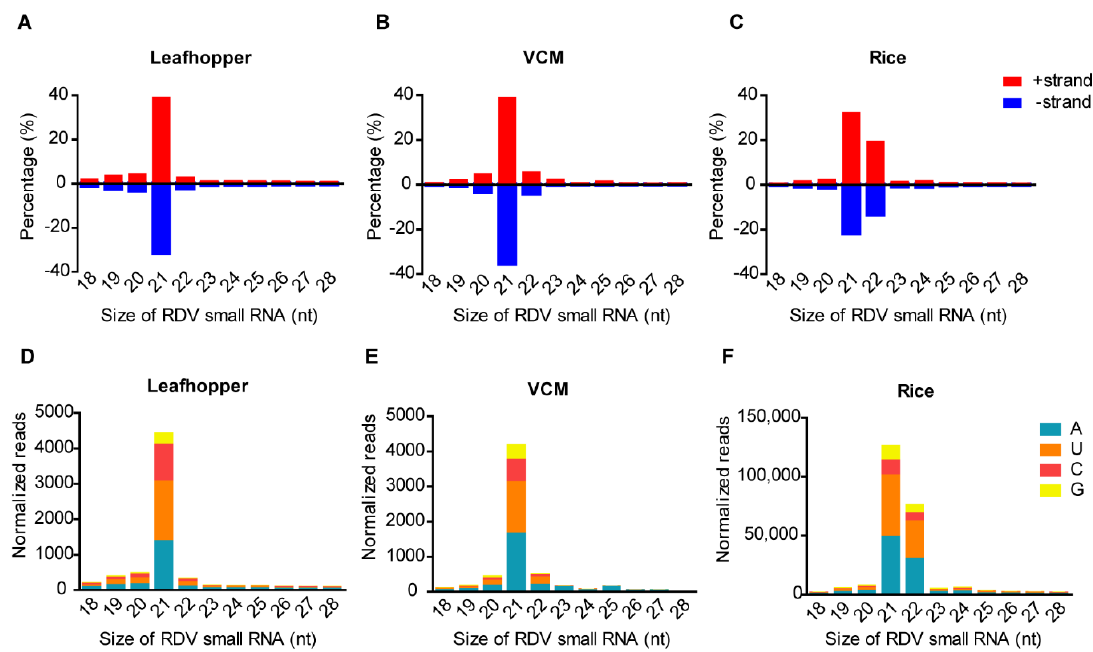
Figure 3. vsiRNA profiles of RDV-infected leafhoppers, VCMs, and rice plants. ( A – C ) Size distributions of RDV-derived small RNAs in the libraries from each species based on deep sequencing data. Percentages of positive-strand (top red bars) and negative-strand (bottom blue bars) vsiRNAs in the length range of 18 to 28 nt are shown. ( D – F ) Base preference for 5 ′ -terminal first nucleotide of vsiRNAs of each length in the three libraries. A, U, C, and G represent adenine, uracil, cytosine, and guanine, respectively.